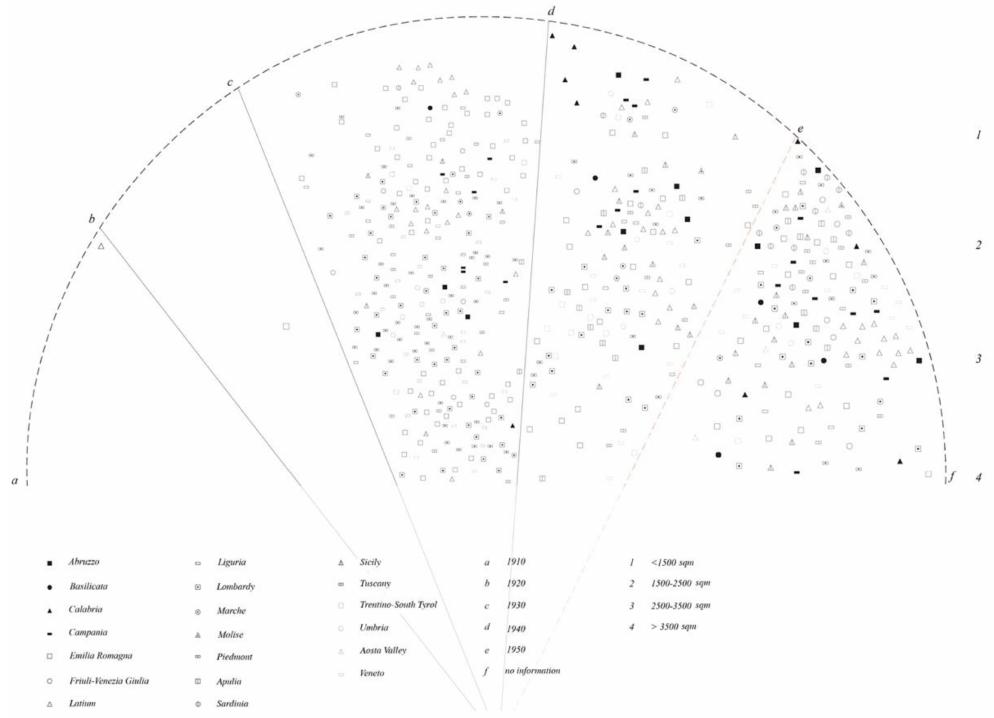
Figure 2. A synoptic and diachronic restitution of the 549 “Case del